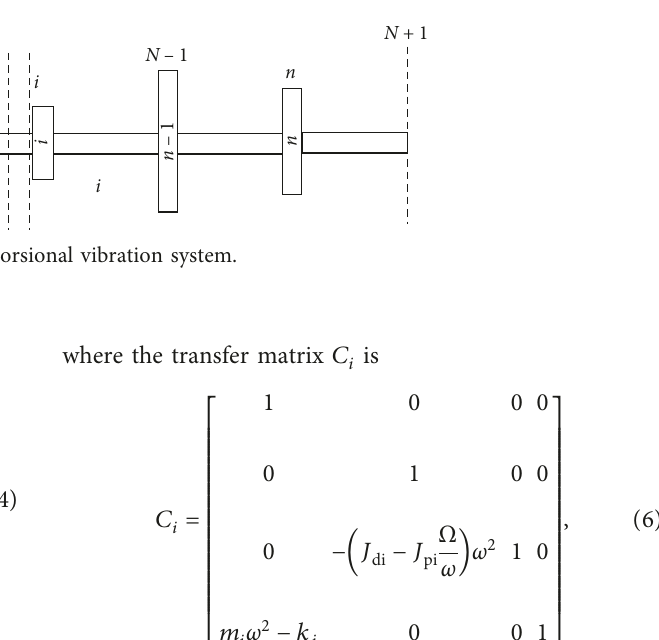
Figure 1: Rotor model and structure drawing.